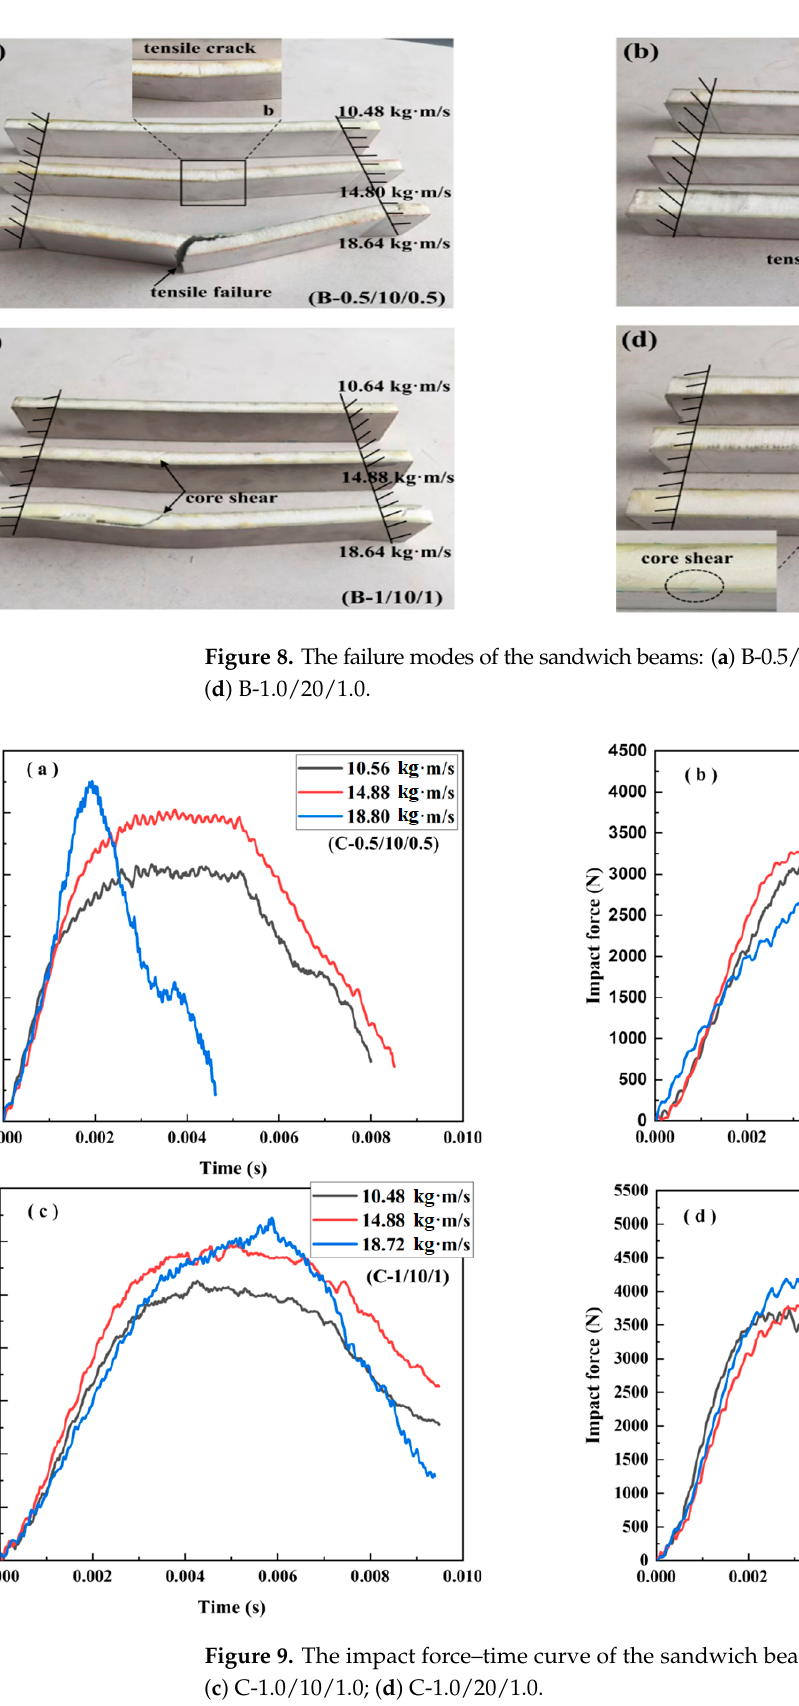
Figure 10. The failure modes of the sandwich beams: ( a ) C-0.5/10/0.5; ( b ) C-0.5/20/0.5; ( c ) C- 1.0/10/1.0; ( d ) C-1.0/20/1.0.